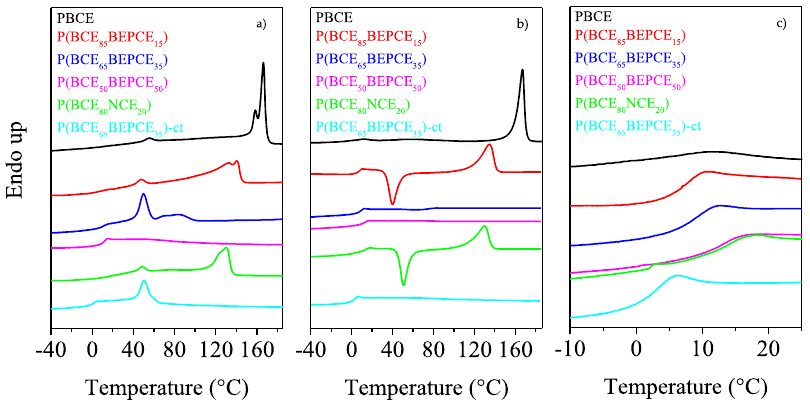
Figure 5. Calorimetric curves (heating rate: 20 °C/min) of PBCE, P(BCE m BEPCE n ), and P(BCE 80 NCE 20 ) copolymers. ( a ) 1st scan and ( b ) 2nd scan after quenching from the melt; ( c ) magnification in the T g region of 2 nd scan.